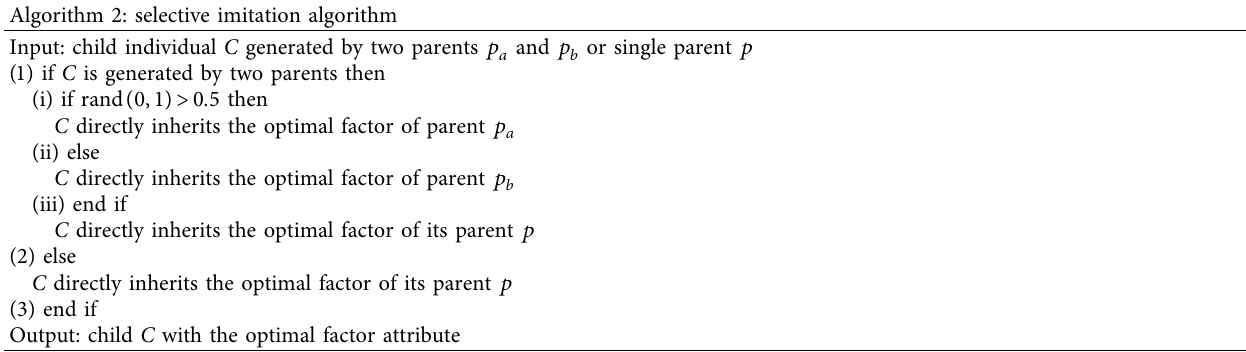
Table 2: Pseudocodes of selective imitation algorithms. Algorithm 2: selective imitation algorithm